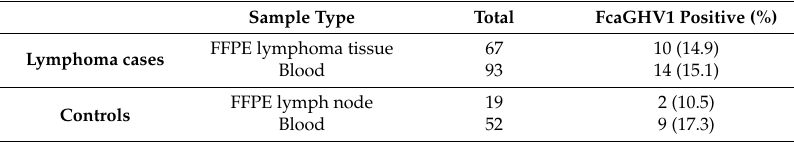
Table 1. FcaGHV1 positive lymphoma cases and controls by sample type.